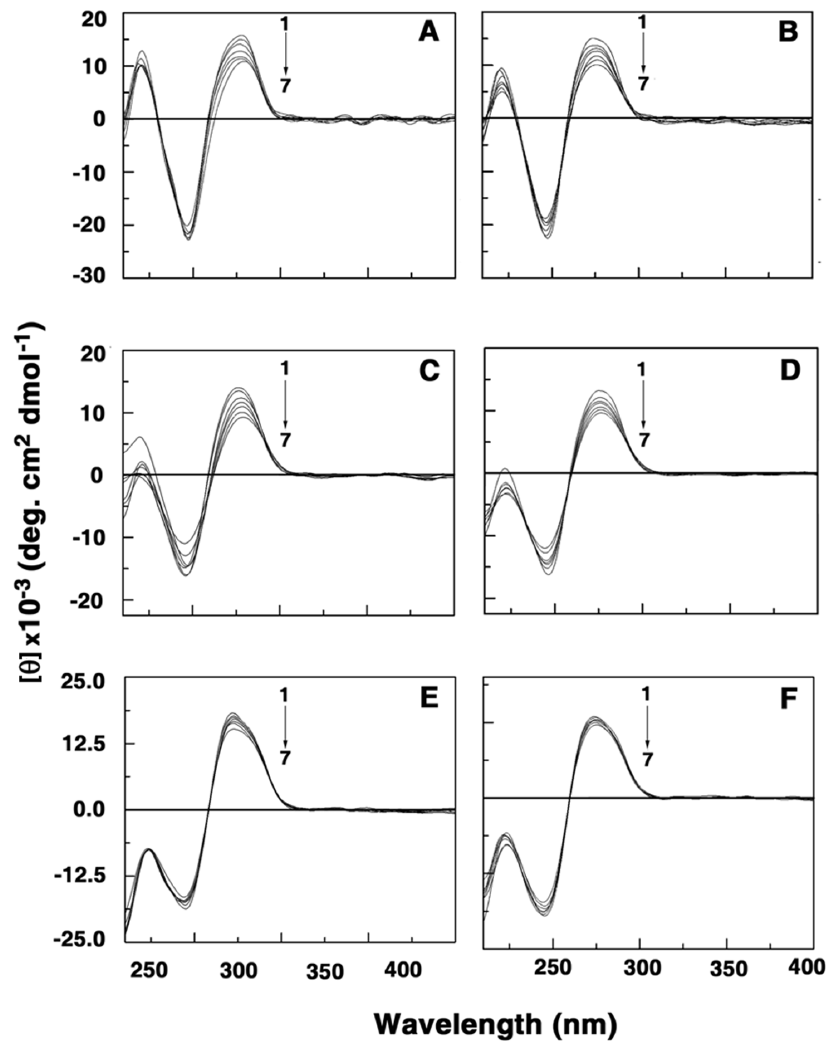
Figure 8. Circular dichroism spectral titration of DNA-poyamine complexes. Intrinsic CD spectra of (A) CP DNA (30 m M) treated with 0– 63 m M (curves 1 to 7) spermine (B) CP DNA (30 m M) treated with 0–135 m M (curves 1 to 7 ) spermidine (C) EC DNA (30 m M) treated with 0–95 m M (curves 1 to 7) spermine (D) EC DNA (30 m M) treated with 0–175 m M (curves 1 to 7) spermidine (E) ML DNA (30 m M) treated with 0–120 m M (curves 1 to 7) spermine and (F) ML DNA (30 m M) treated with 0–250 m M (curves 1 to 7 ) spermidine at 293.15 K.